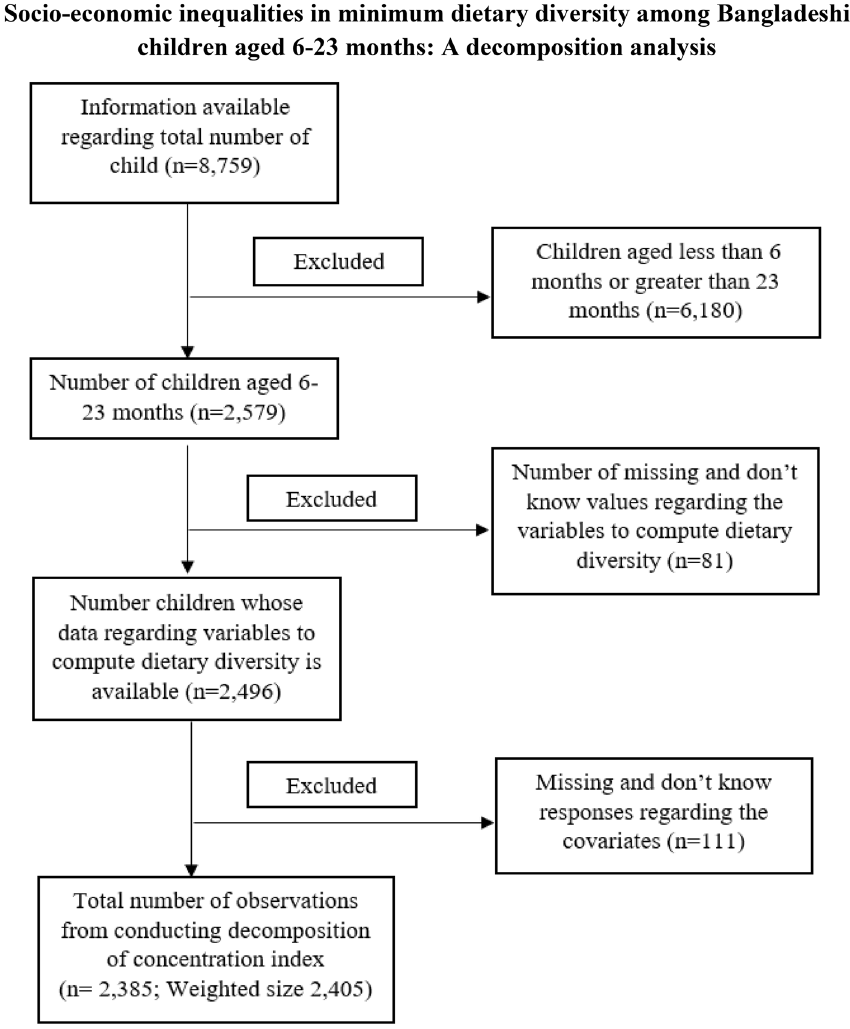
Figure 1. Flowchart of the how the used sample size ultimately